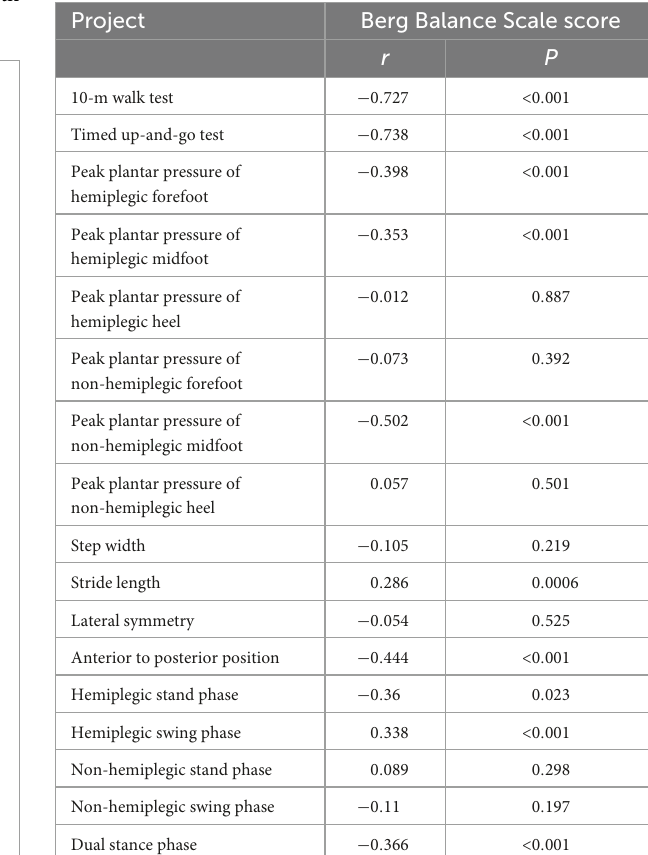
TABLE 3 Correlations between the Berg Balance Scale score and peak plantar pressure and gait parameters in the study